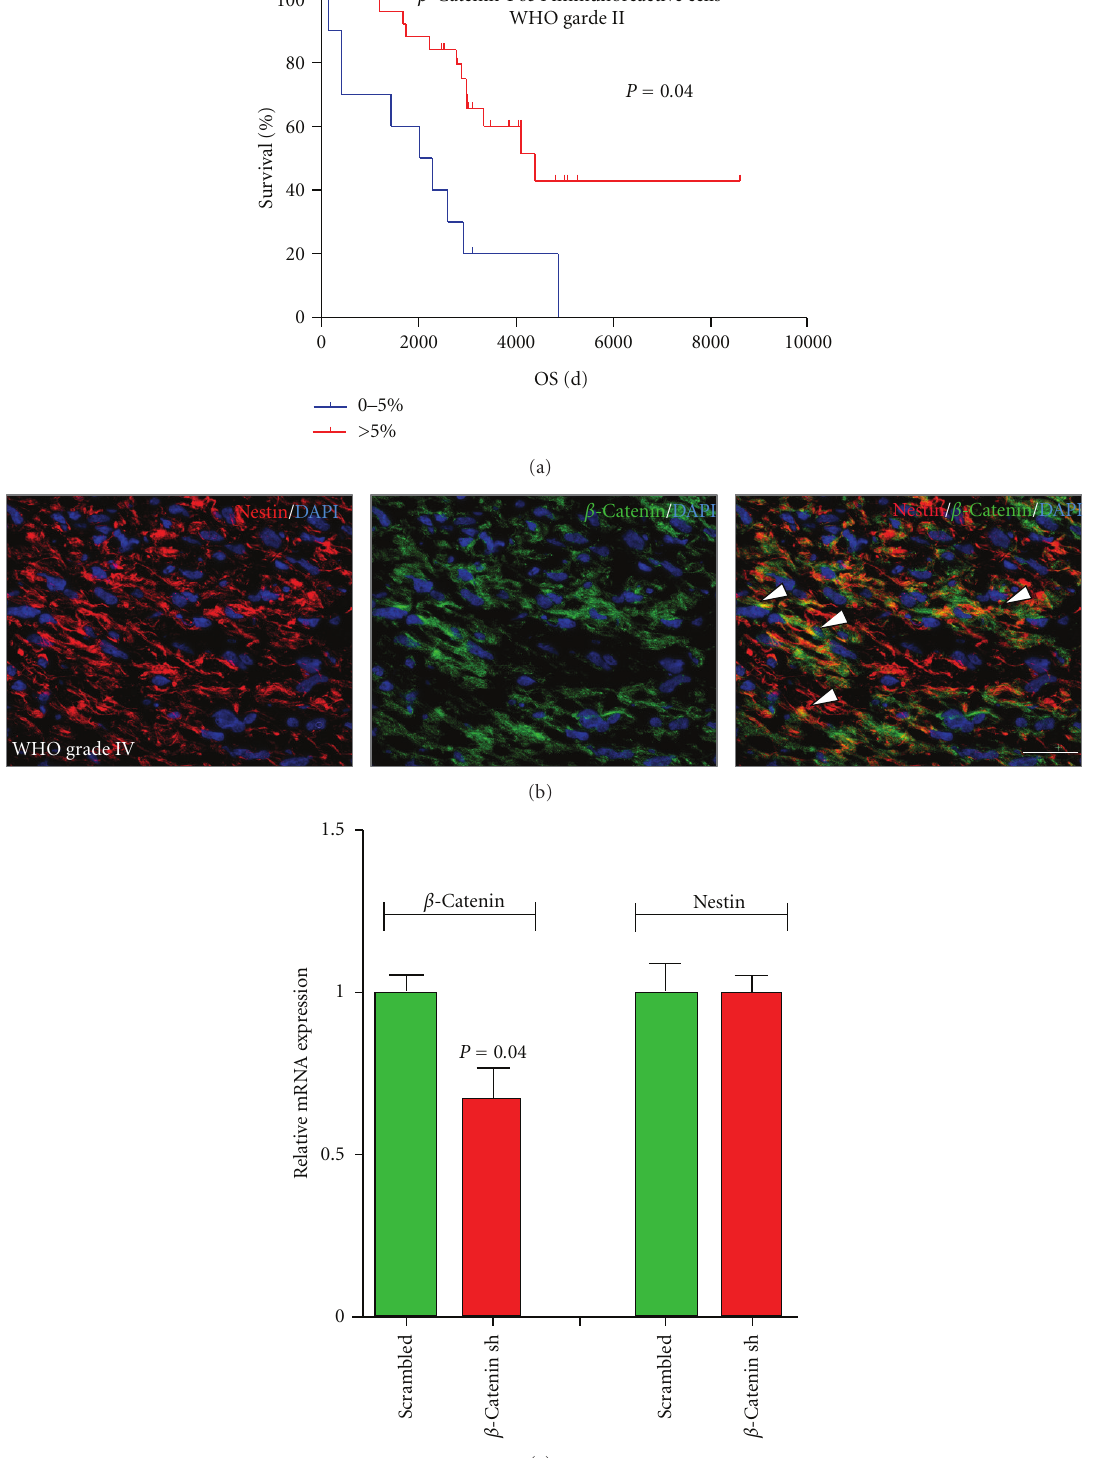
Figure 4: (a) Kaplan-Meier plot illustrating the correlation of patient outcome with β -catenin-P654 expression levels in the subgroup of low-grade astrocytomas. Expression of β -catenin-P654 is directly associated with a prolonged overall survival (OS). P value represents multivariate associations of staining frequencies with OS. (b) Immunofluorescence staining showing colocalization of the stem cell- associated filament protein nestin (red) and β -catenin (green). DAPI (blue) was used for nuclear counterstaining. Representative staining is shown in a primary glioblastoma tissue (white arrow heads represent double-positive cells; scale bars represent 150 μ m). (c) Graphs show β -catenin and nestin mRNA expression in NCH421k cells infected with scrambled control or a shRNA directed against β -catenin. Data are shown as mean values ± SEM of four technical